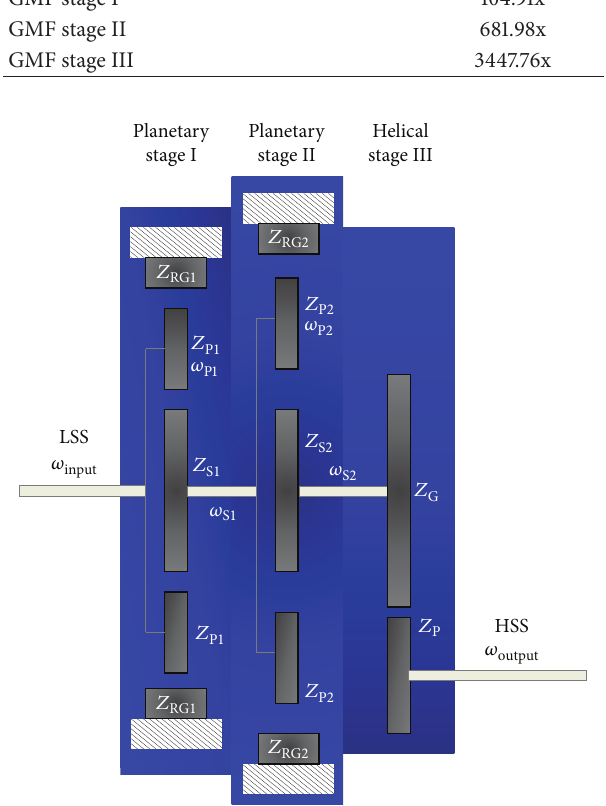
Figure 12: Sketch of the Vestas V90-3MW gearbox